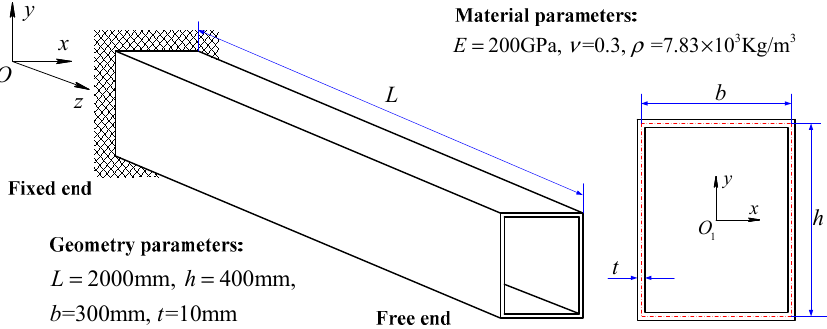
Figure 4. A cantilevered thin-walled structure with geometry and material parameters as shown for modal analyses.